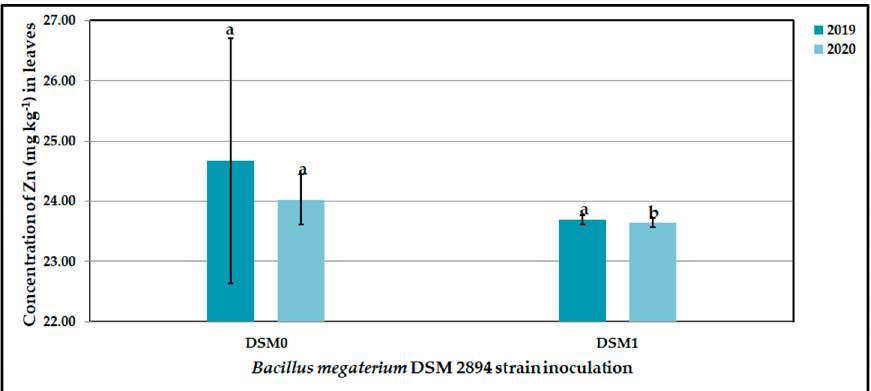
Figure 7. Influence of Bacillus megaterium DSM 2894 var. on leaf zinc (Zn, mg kg − 1 ) contents of CaCO 3 ‐ stressed sweet potato plants in 2019 and 2020 seasons. Bars with a different letter indicate significant difference between treatments at p ≤ 0.05. DSM 0 = non ‐ inoculated with Bacillus megaterium DSM 2894 var., DSM 1 = inoculated with Bacillus megaterium DSM 2894 var.